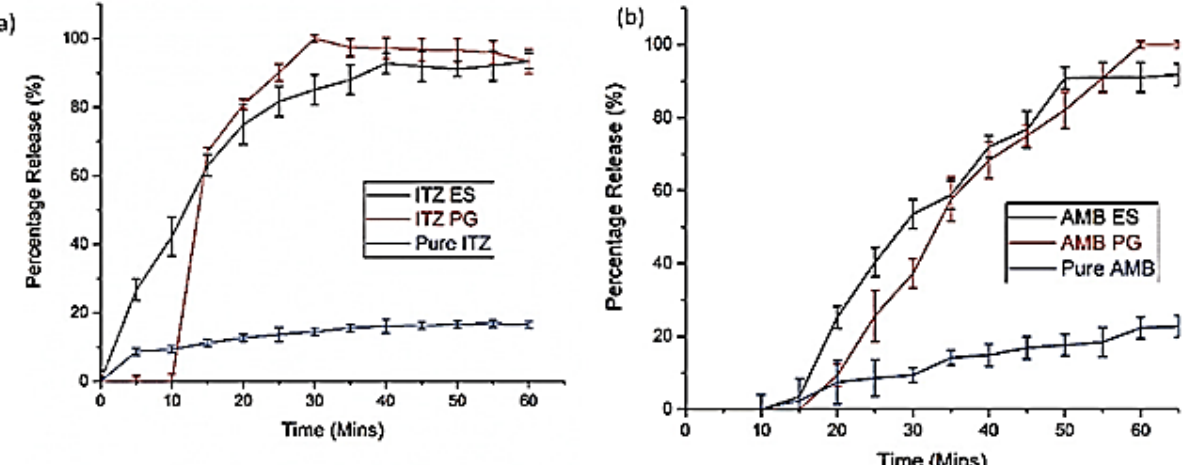
Figure 25. In vitro dissolution profiles of ( a ) Itraconazole-loaded fibres and ( b ) amphotericin B fibres. Reproduced with permission from [177]. Copyright 2018 WILEY-VCH.